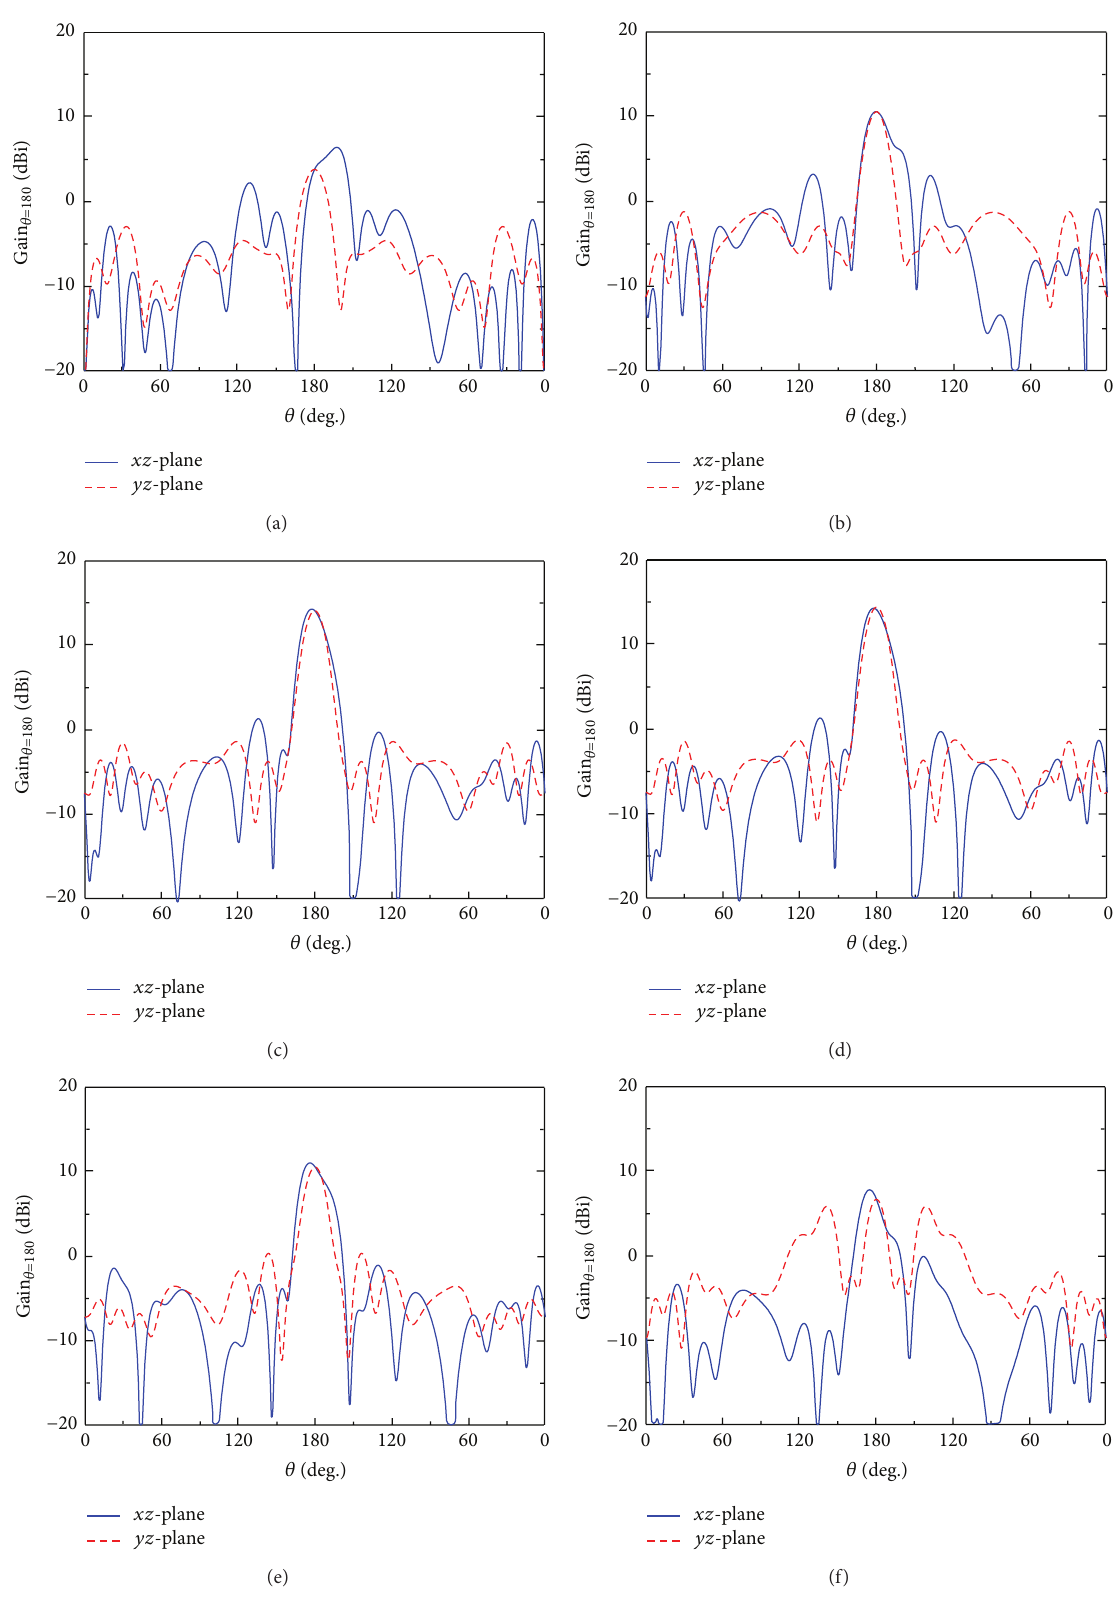
Figure 10: Simulated radiation patterns of the optimized antenna at different frequencies: (a) 21.4GHz, (b) 21.5GHz, (c) 21.6 GHz, (d) 21.7 GHz, (e) 21.8 GHz, and (f)